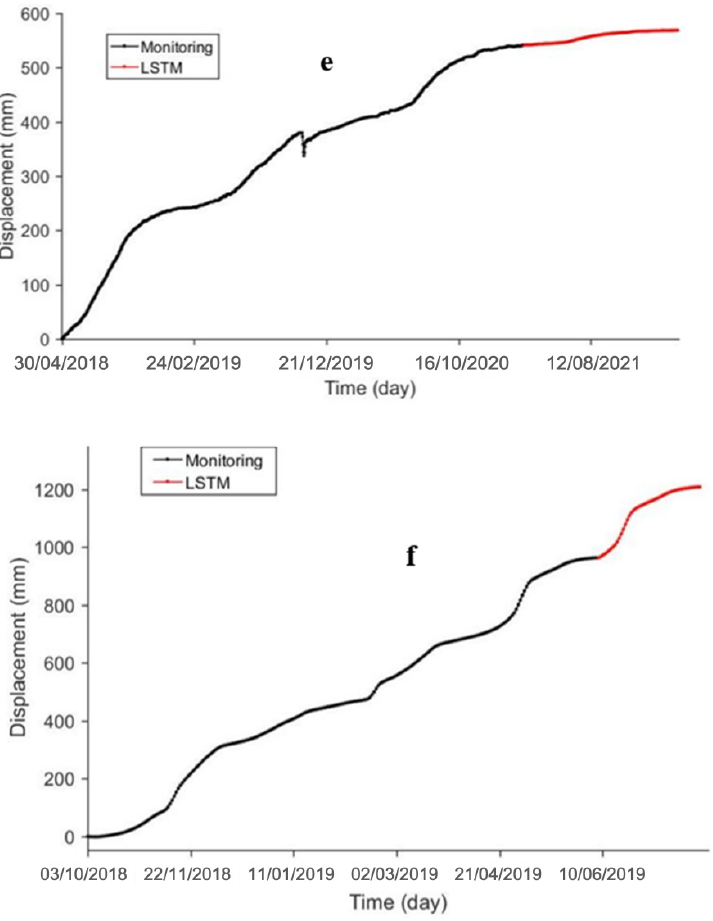
Figure 10. LSTM deformation prediction of monitoring station YII5-1. ( a ) YII5-1 model training. ( b ) YII5-1 model testing. ( c ) CX01 EL 1205 model training. ( d ) CX01 EL 1205 model testing. ( e ) YII5-1prediction results, and ( f ) CX01 EL 1205 prediction results.